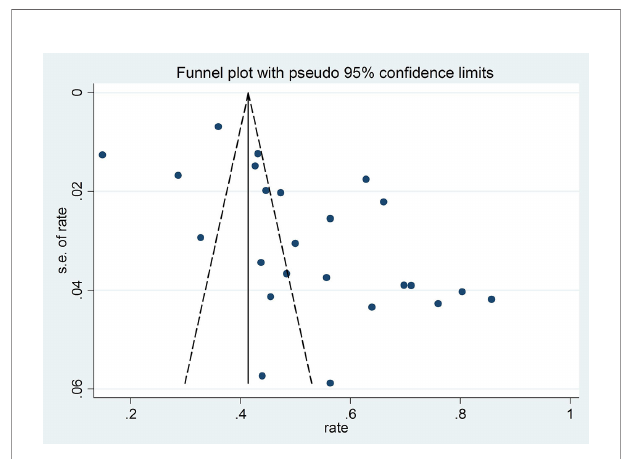
FIGURE 3 | Funnel plot of publication bias for 24 studies with available data on prevalence of poor sleep